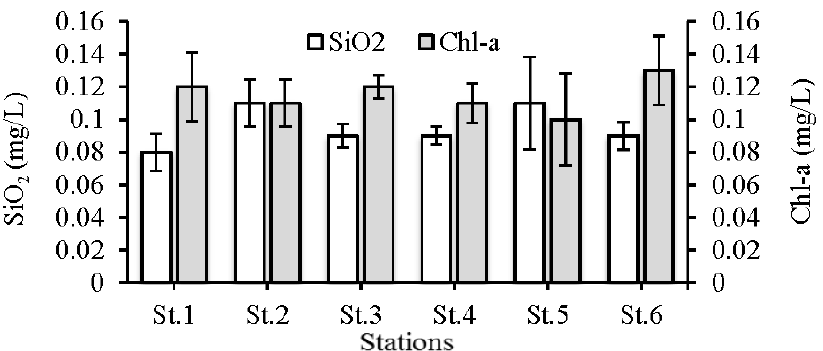
Figure 3. Variations in seawater nutrients (mean ± SD) along the Port Dickson coasts, Malaysia: nitrate (NO 3 – ) and nitrite (NO 2 – ); ammonia (NH 3 ) and phosphate (PO 4 −3 ); and chlorophyll-a (Chl-a) and silica (SiO 2 ).